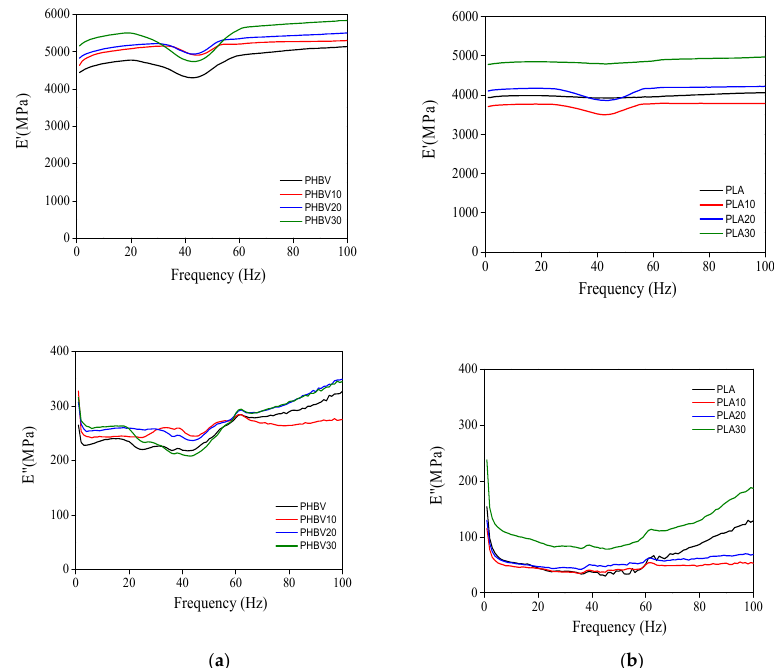
Figure 4. Storage modulus ( E ′ ) and loss modulus ( E ″ ) at different frequencies for PHBV ( a ) and PLA ( b ) biocomposites at room temperature (Standard deviation for E’: ± 200 MPa for reinforced samples and ±25 MPa for pristine samples; Standard deviation for E ’’: ±2 MPa).